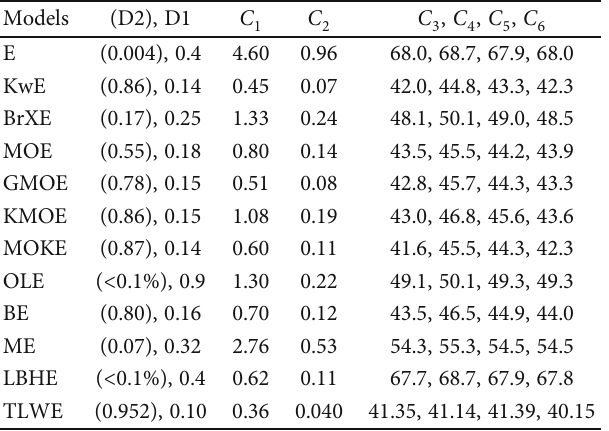
Table 4: Statistic for the relief time data.